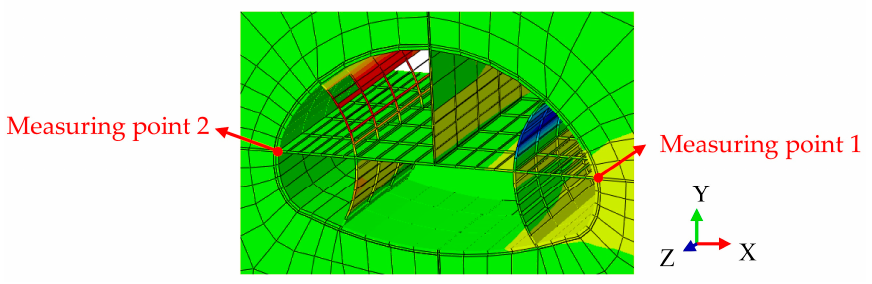
Figure 9. The measuring points of horizontal displacement.